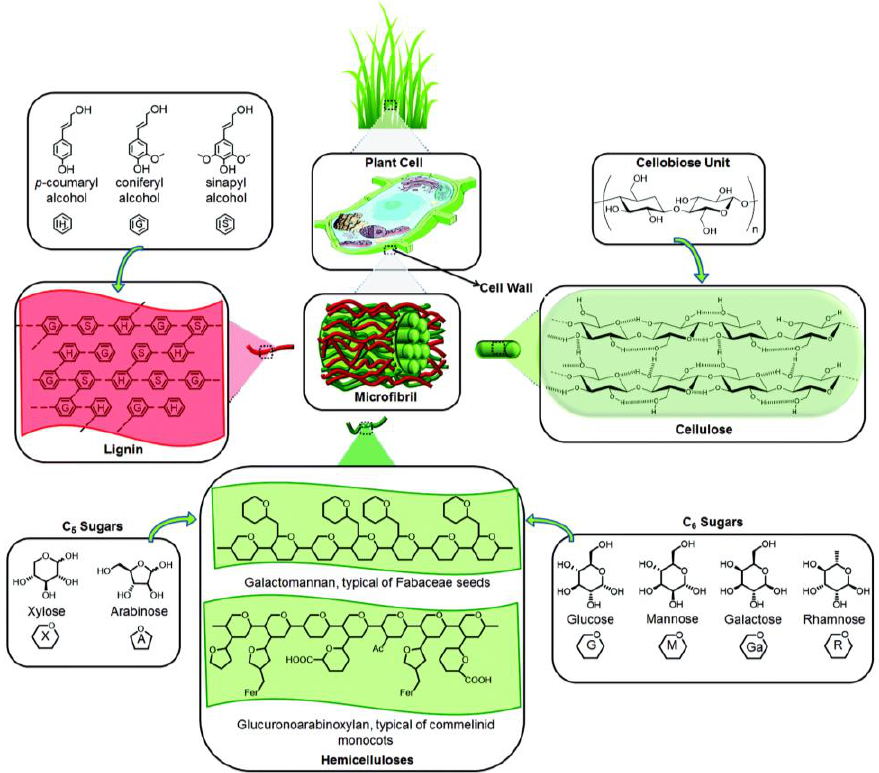
Figure 2. Main structural components of a lignocellulosic material (reproduced from Isikgor and Becer [14] with permission from the Royal Society of Chemistry, 2015).